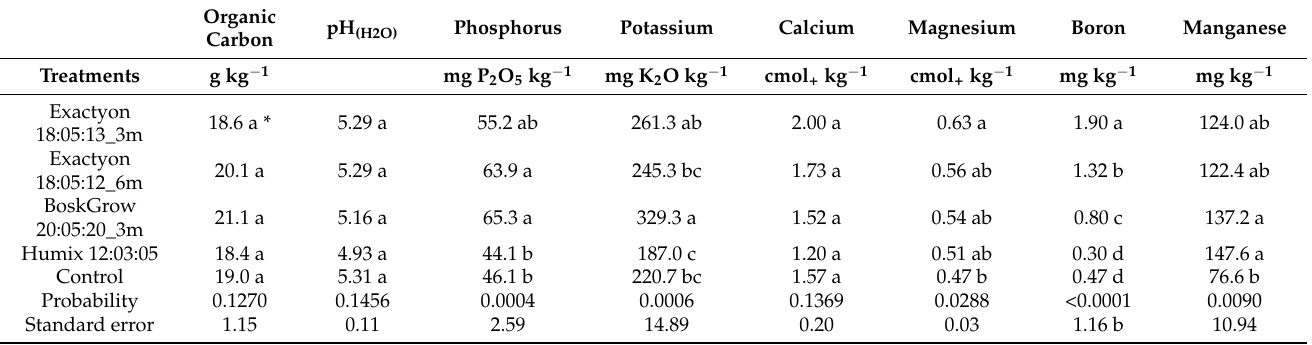
Table 4. Selected soil properties determined from composite soil samples (n = 4) taken at 0–0.20 m in October 2021 in the plots of the different fertilization treatments.